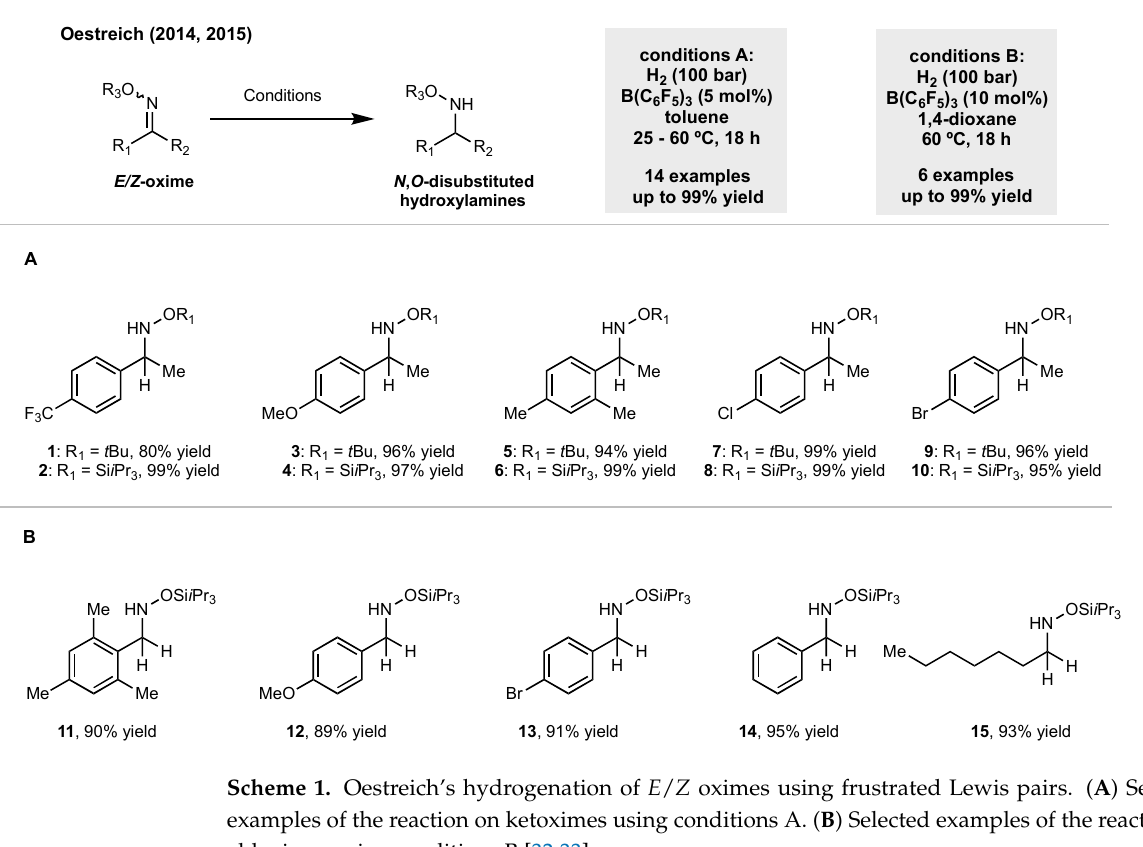
6 examples up to 99%